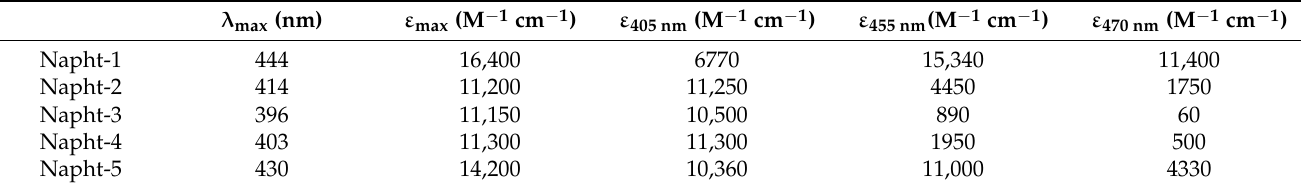
Table 1. Absorption properties of Napht-1-Napht-5 at different wavelengths (405 nm, 455 nm, 470